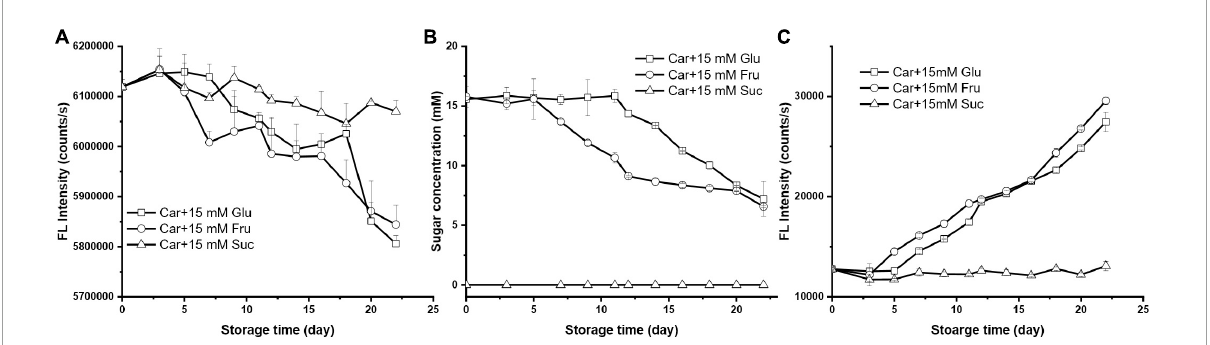
FIGURE2 The changes of (A) carnosine florescence intensity, (B) sugar concentration, and (C) the formation of MRP during storage (the initial mixture contained 10 mM carnosine with 15 mM glucose, fructose, or sucrose).